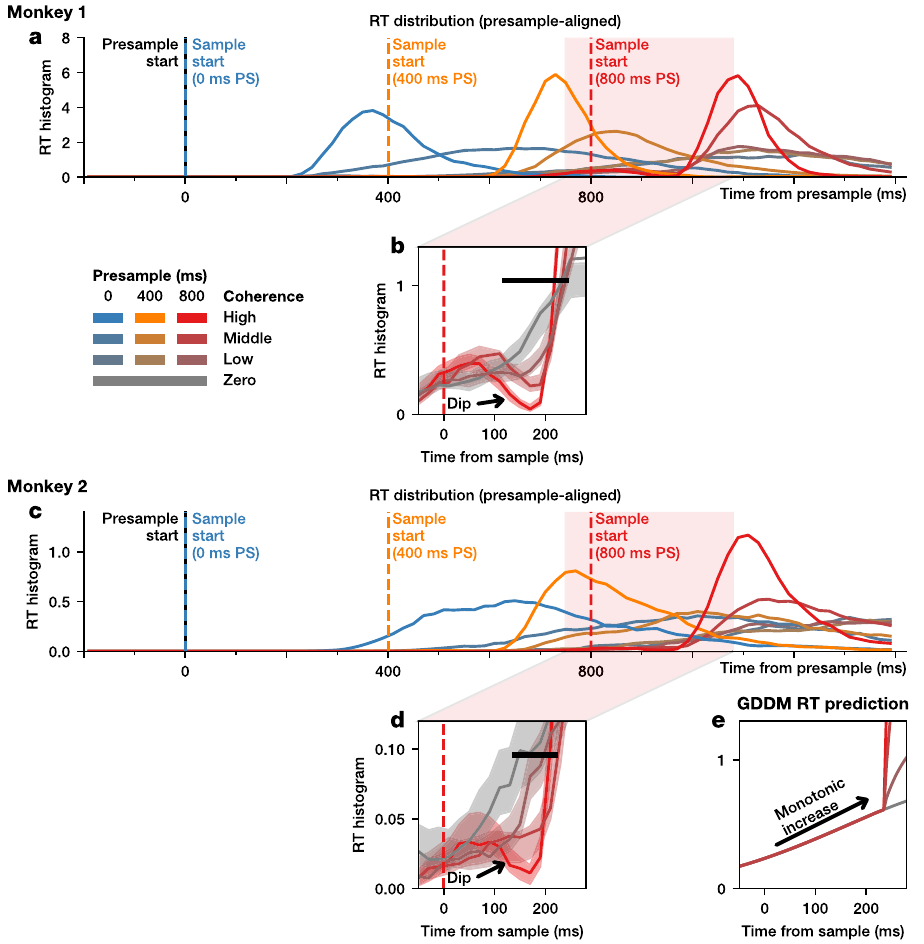
Fig. 2 Transient effect of changes in evidence on RT. The RT distribution for all trials, aligned to the presample onset, for Monkey 1 ( a ) and Monkey 2 ( c ). The RT distribution centered around the onset of the sample during trials with 800-ms presample for Monkey 1 ( b ) and Monkey 2 ( d ). e Predictions from a generalized drift-diffusion model (GDDM) for the portion of the RT distribution shown in ( b , d ). The black bar indicates signi fi cance ( p < 0.05, one-tailed test for a decrease in the mean, bootstrapping across trials). Shaded regions represent bootstrapped 95% con fi dence interval of the mean. RT distributions are smoothed for visualization only, with signi fi cance tests performed before